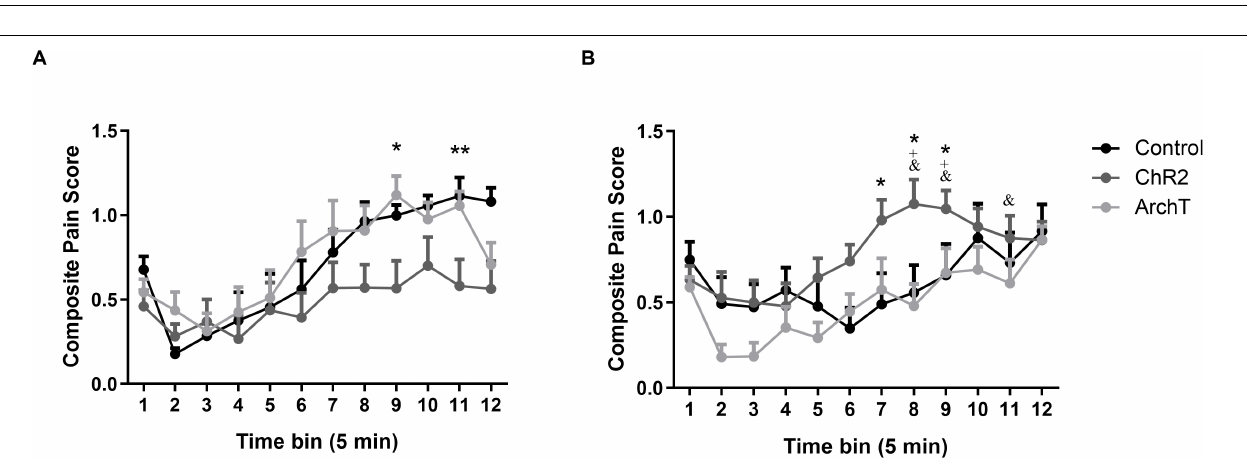
FIGURE 3 | (A) Effects of optogenetic stimulation (ChR2) or inhibition (ArchT) of glutamatergic neurons in the ACC on formalin-evoked nociceptive behavior of male Sprague-Dawley rats. Data are mean ± SEM ( n = 8–10 per group). ** p < 0.01, * p < 0.05 ChR2 vs control. (B) Effects of optogenetic stimulation (ChR2) or inhibition (ArchT) of glutamatergic neurons in the ACC on formalin-evoked nociceptive behavior of female Sprague-Dawley rats. Data are mean ± SEM ( n = 7–11 per group). * p < 0.05 ChR2 vs control. + p < 0.05 ChR2 female vs ChR2 male, and & p < 0.05 ArchT female vs ArchT male.